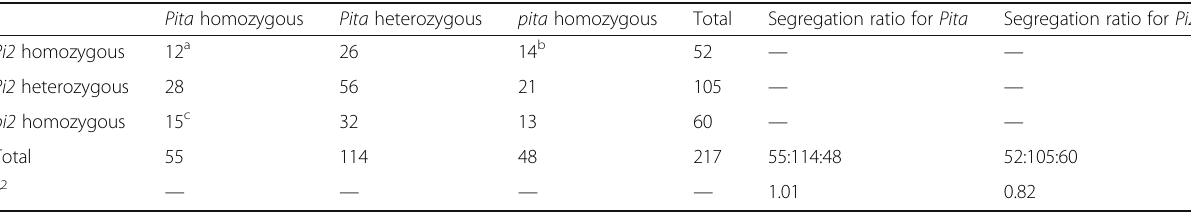
Table 3 Results of genotypes based on Ind306 and Pita -based marker among the 217 pi46 homozygous plants Pita